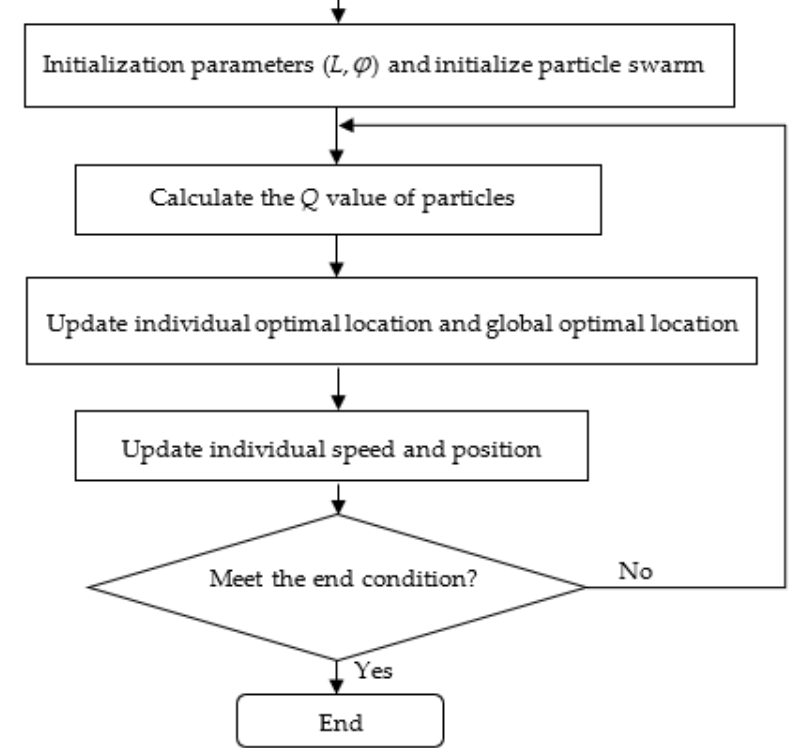
Figure 6. Process of POIF.